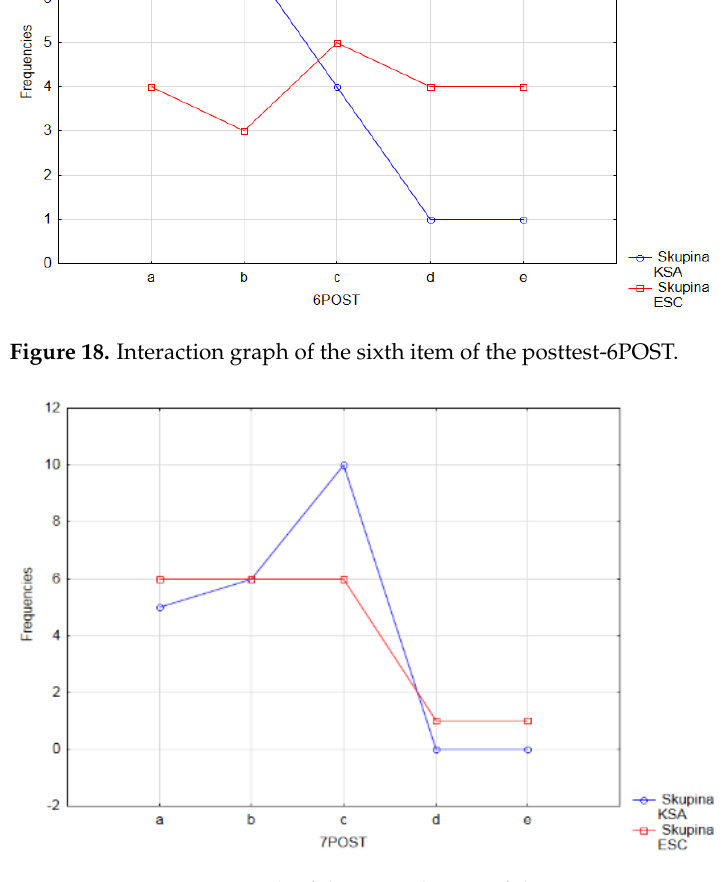
Figure 19. Interaction graph of the seventh item of the posttest - 7POST.